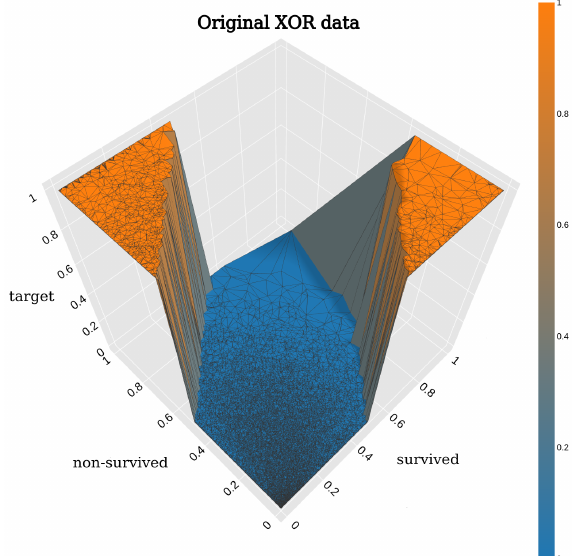
Figure 5. The original XOR data. The values on the x-axis correspond to the feature “survived”, the values on the y-axis correspond to the feature “non-survived” and the corresponding inverted values of the “target” are on the z-axis.